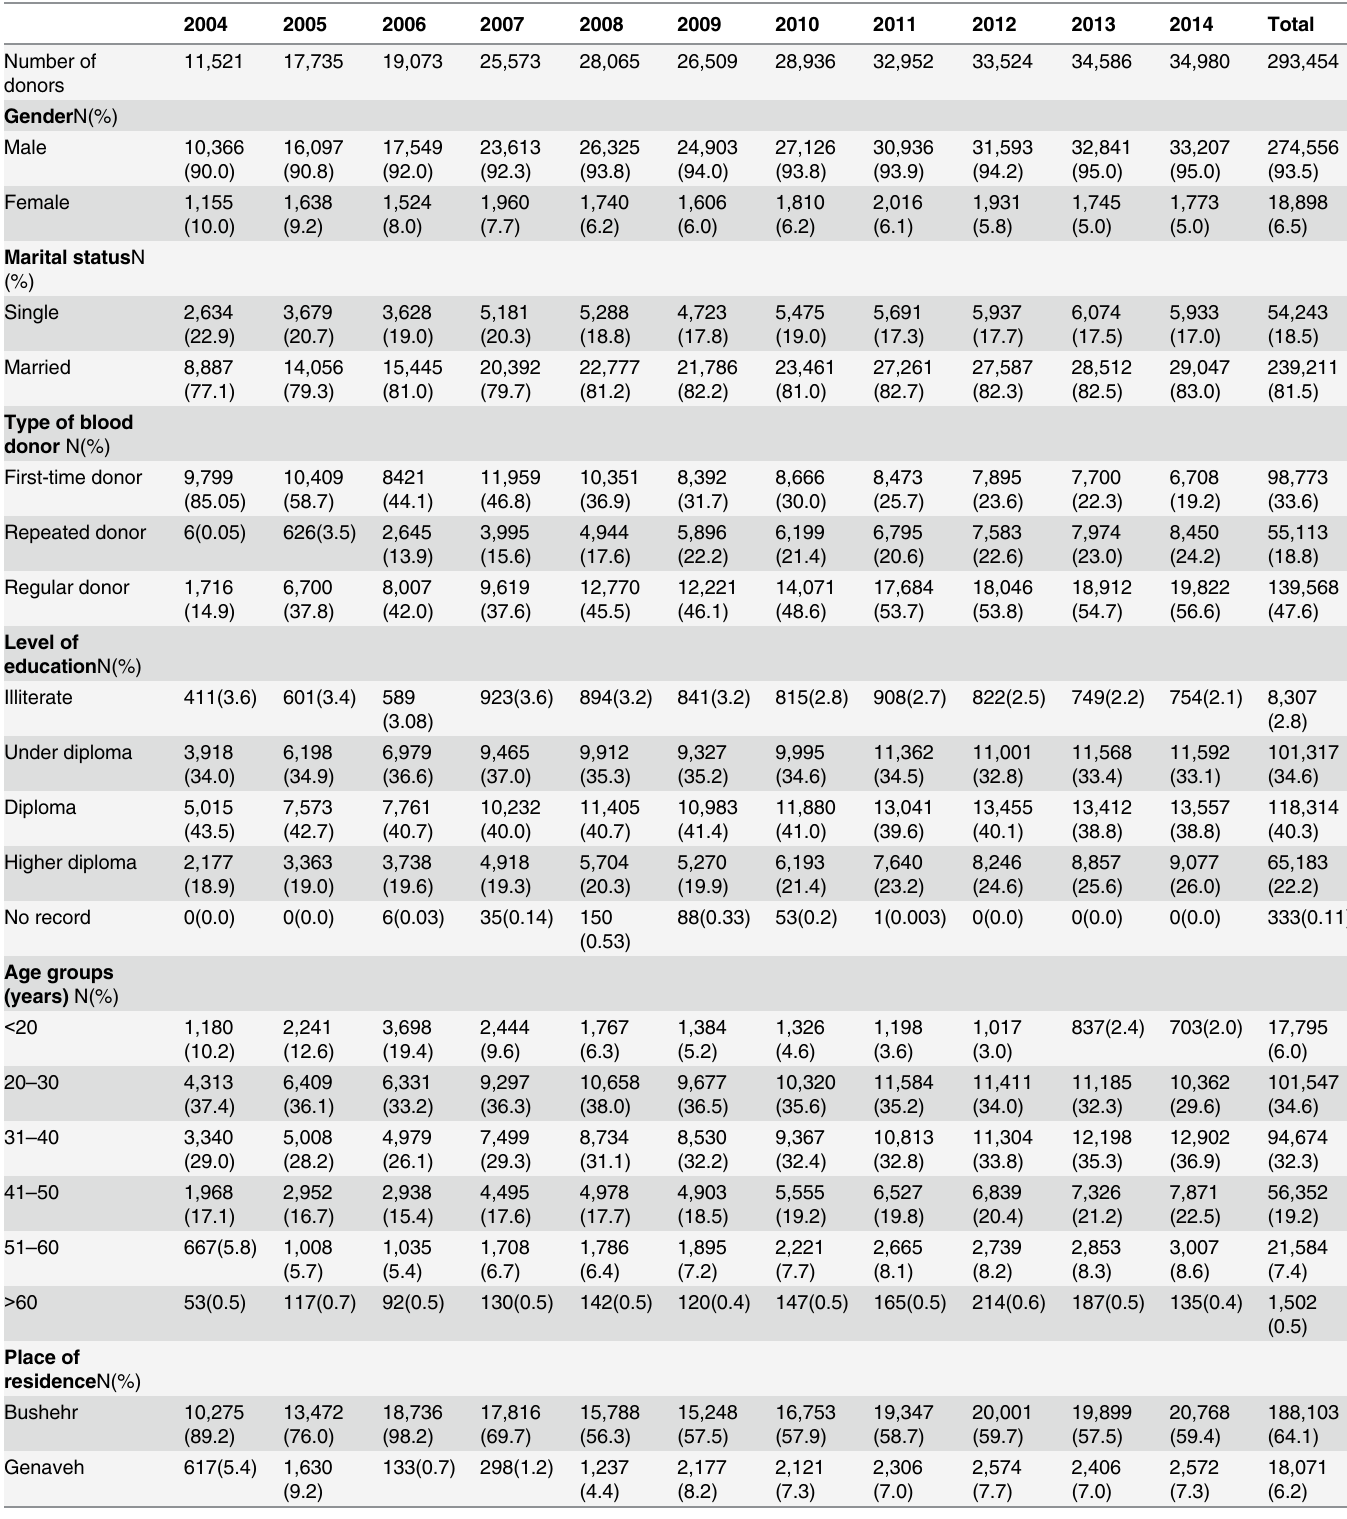
Table 2. Socio-demographic characteristics of blood donors in south of Iran, 2004 –